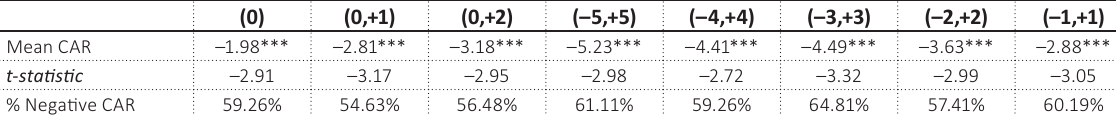
Table 3. Cumulative abnormal returns around rights issue announcements: Family firms